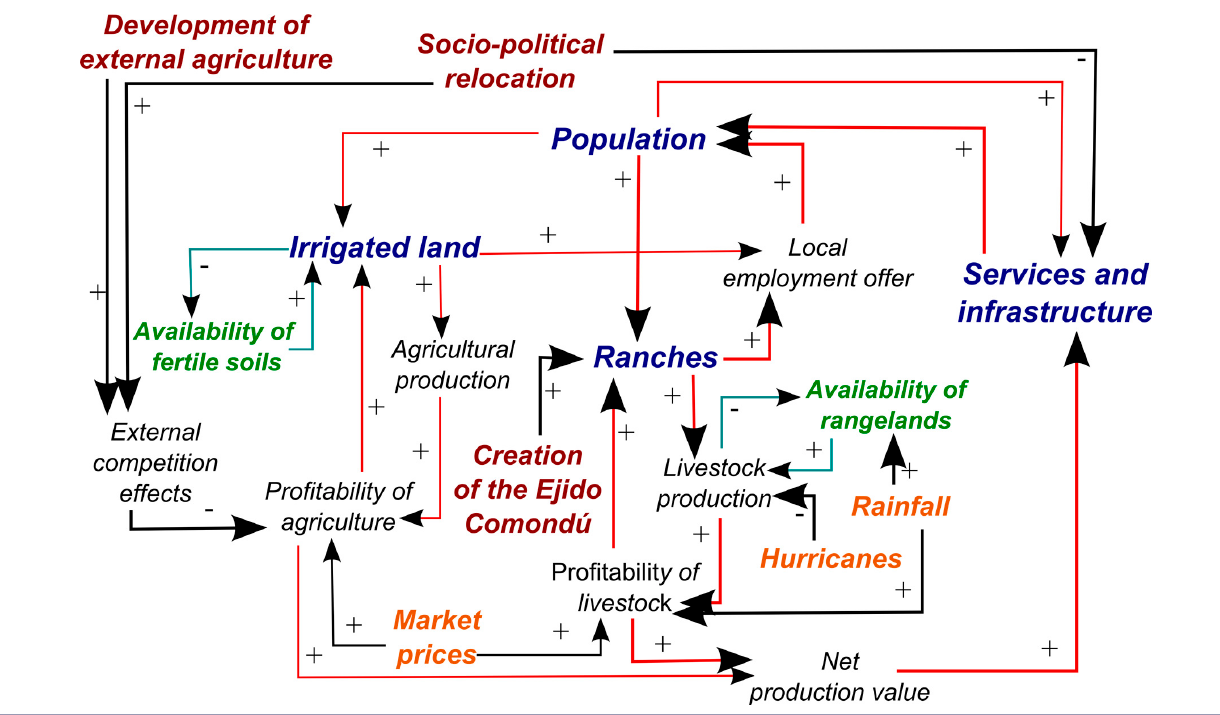
Fig. 13 . The causal diagram with the effects of new external conditions. These new external conditions are marked in red. In this case, the feedback loops associated with livestock activity are larger because they have a heavier relative weight in the system. The system’s positive feedback loops were changed to red because it emphasizes the change in dynamics from growth to a reduction, and now they are vicious